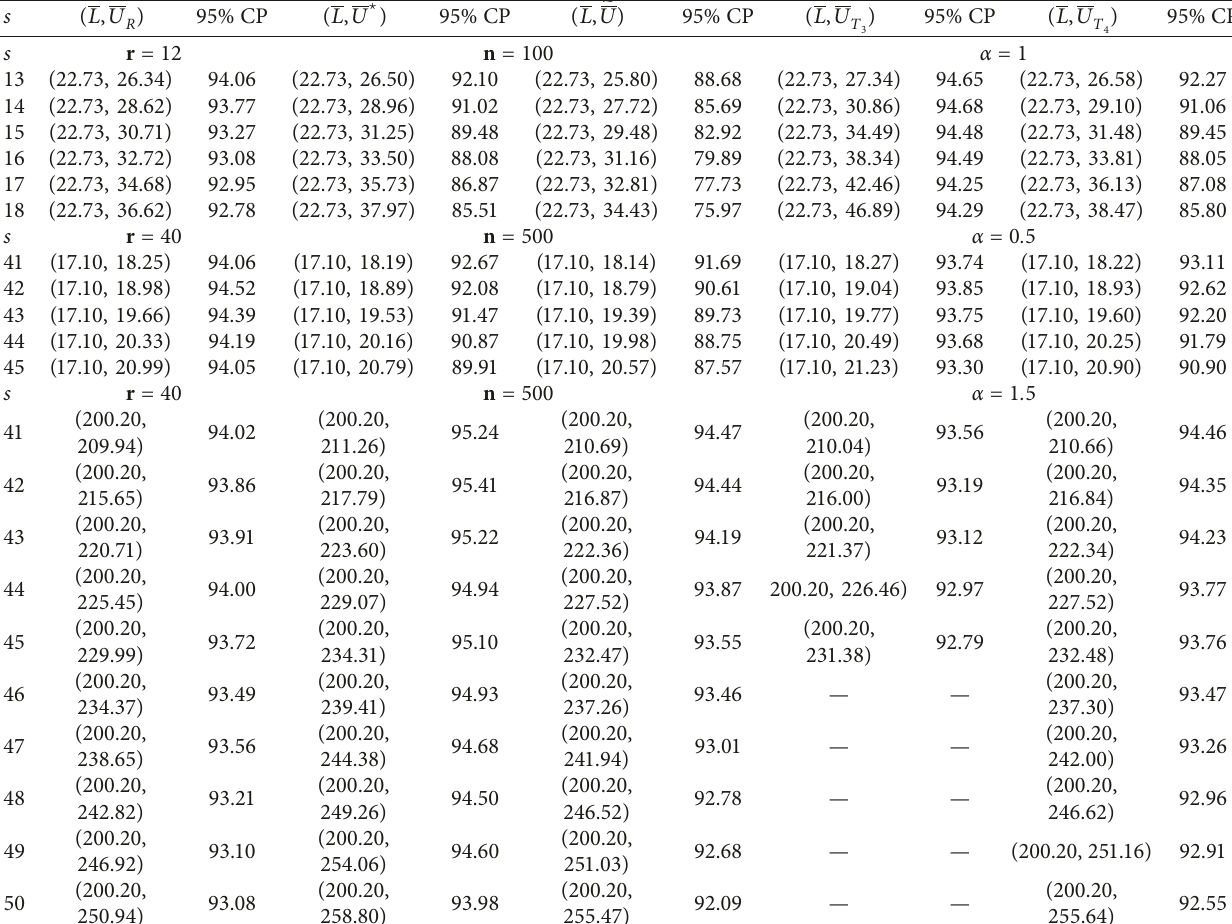
s : n when α and the left endpoint are unknown based on the Weibull DF ) , for different values of α . α